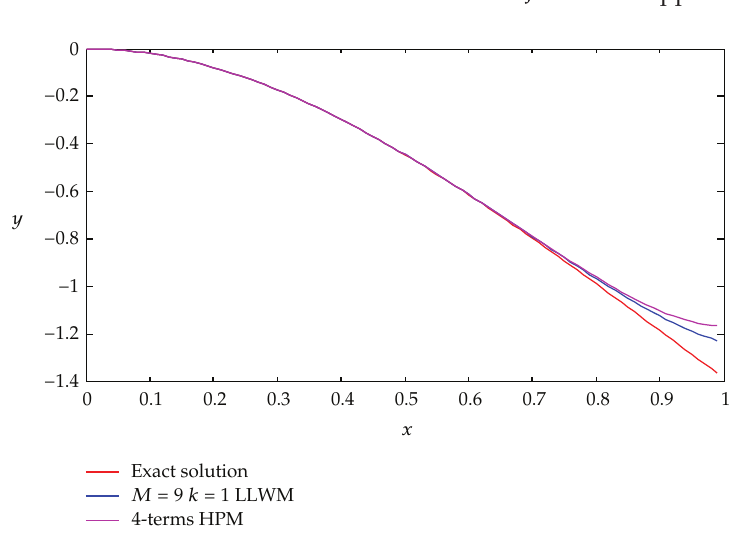
Figure 6: Numerical solution of Example